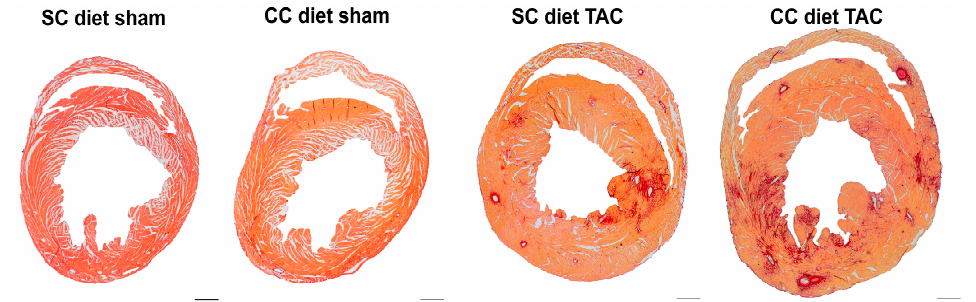
Figure 2. Representative Sirius red-stained cross-sections of sham hearts and TAC hearts at Day 56 after intervention. Scale bar represents 1 mm.